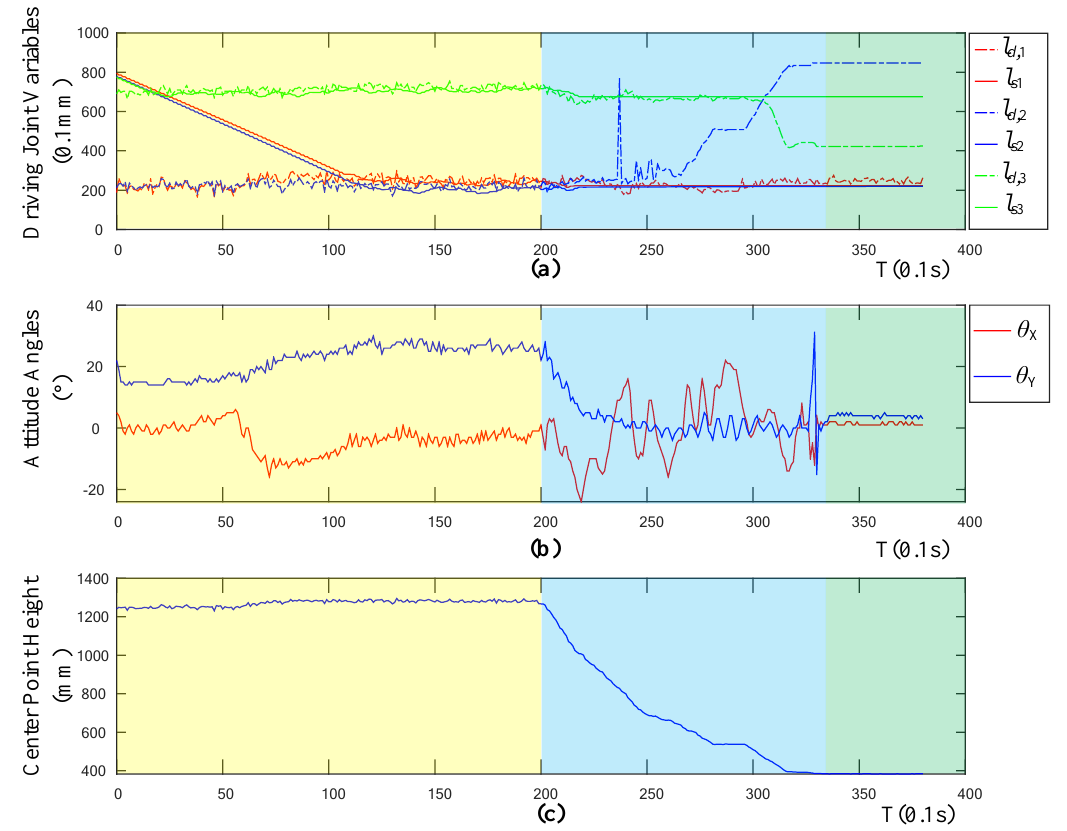
Figure 12. ( a ) Diagram of driving joint variables, ( b ) attitude angles, and ( c ) center point height.